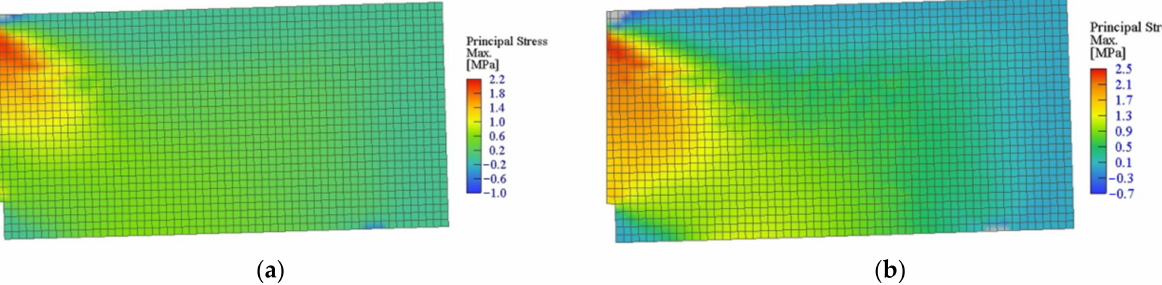
Figure 17. Maximum principal stress in all models for CMOD = 0.5 mm: ( a ) 0.5% and ( b ) 1.5%.